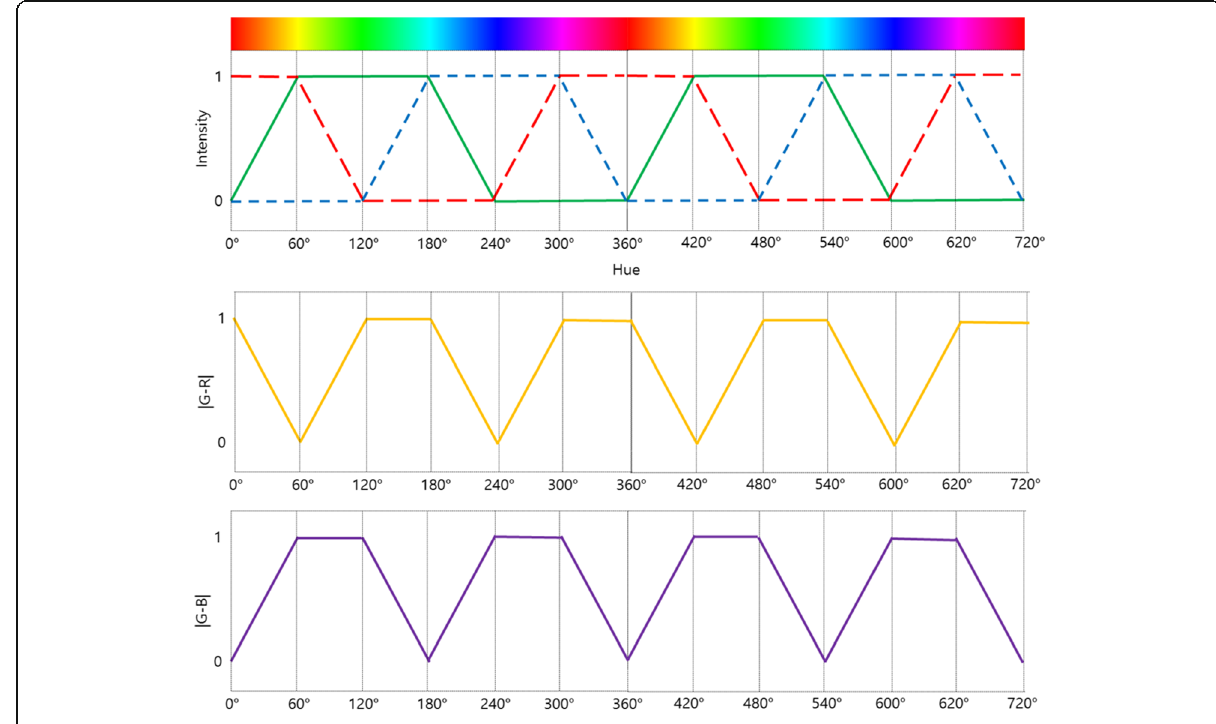
Fig. 5 The 180° periodicity of the absolute values of color differences